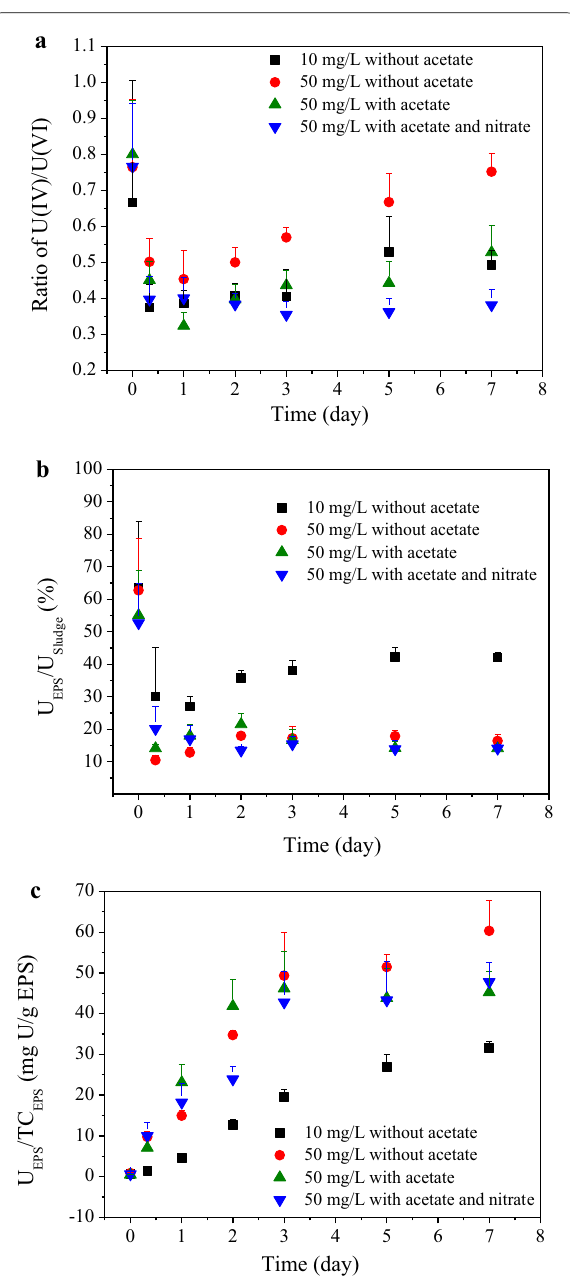
Fig. 4 Variations of: a ratio of U(IV)/U(VI); b U EPS /U Sludge and c U EPS /